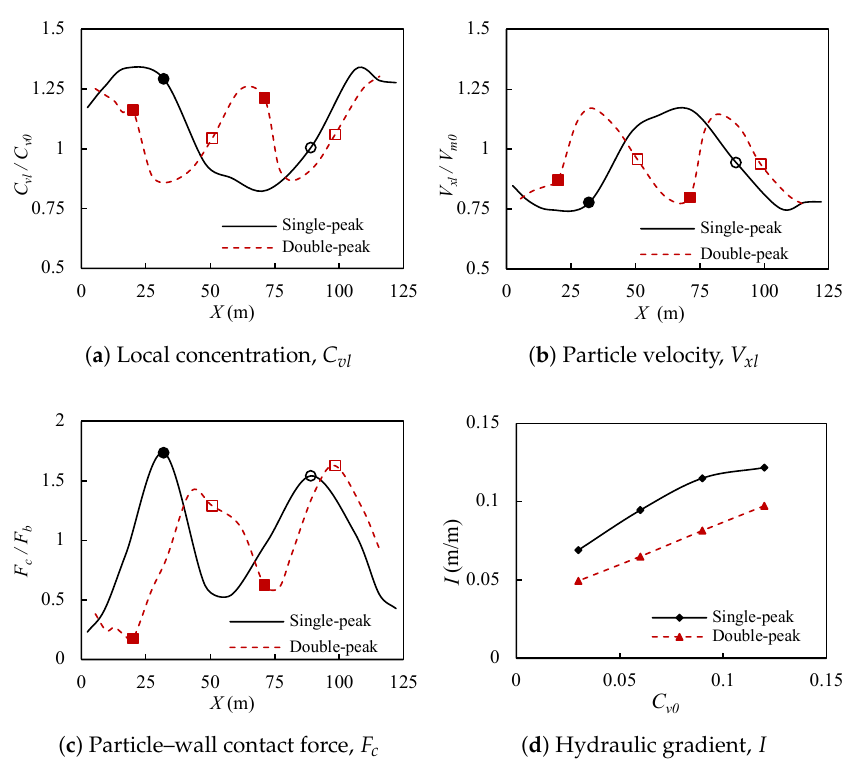
Figure 15. Comparison between the mixtures in single-peak and double-peak risers. In ( a – c ), the solid markers represent the peak and the hollow markers label the